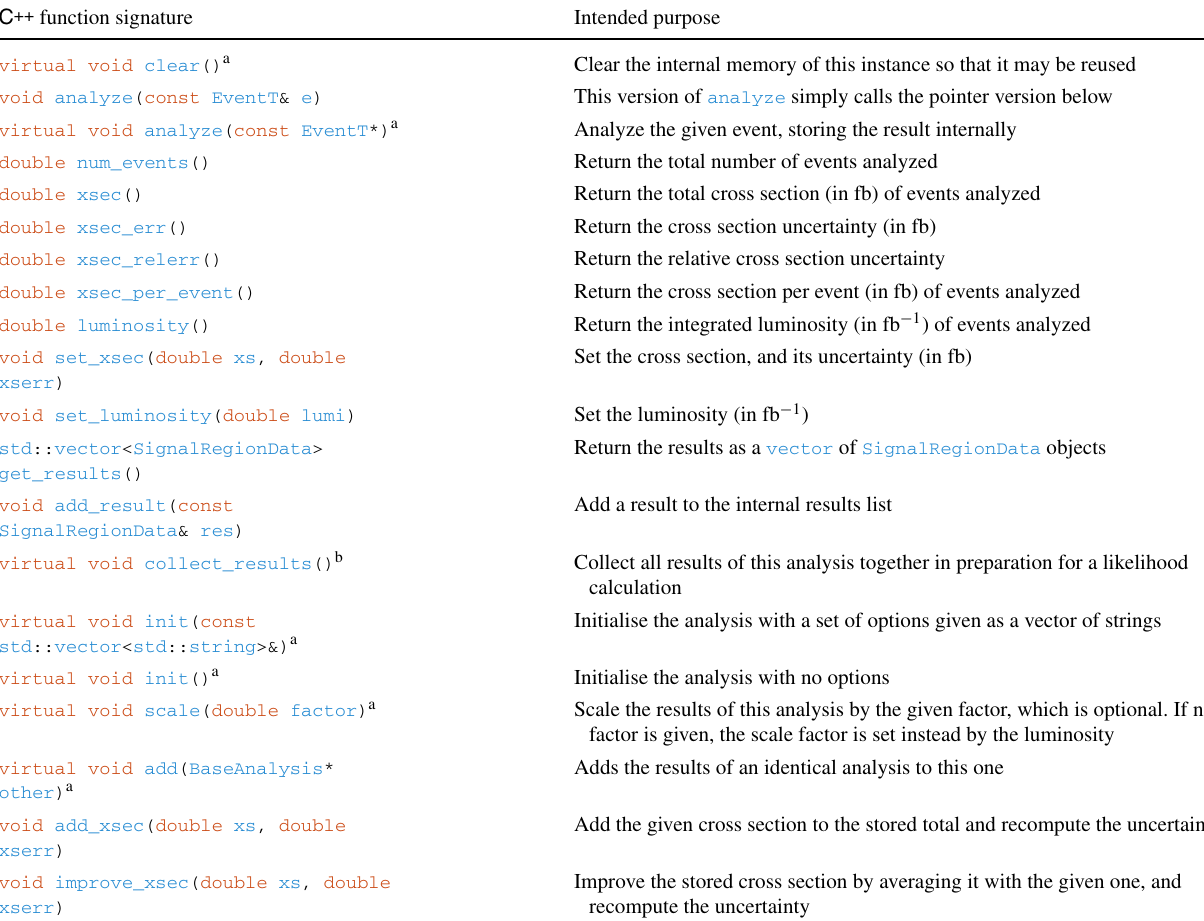
Table17 Inheritedfunctionsforsubclassesof BaseAnalysis<EventT> . Functions that are virtual and marked with a perform only